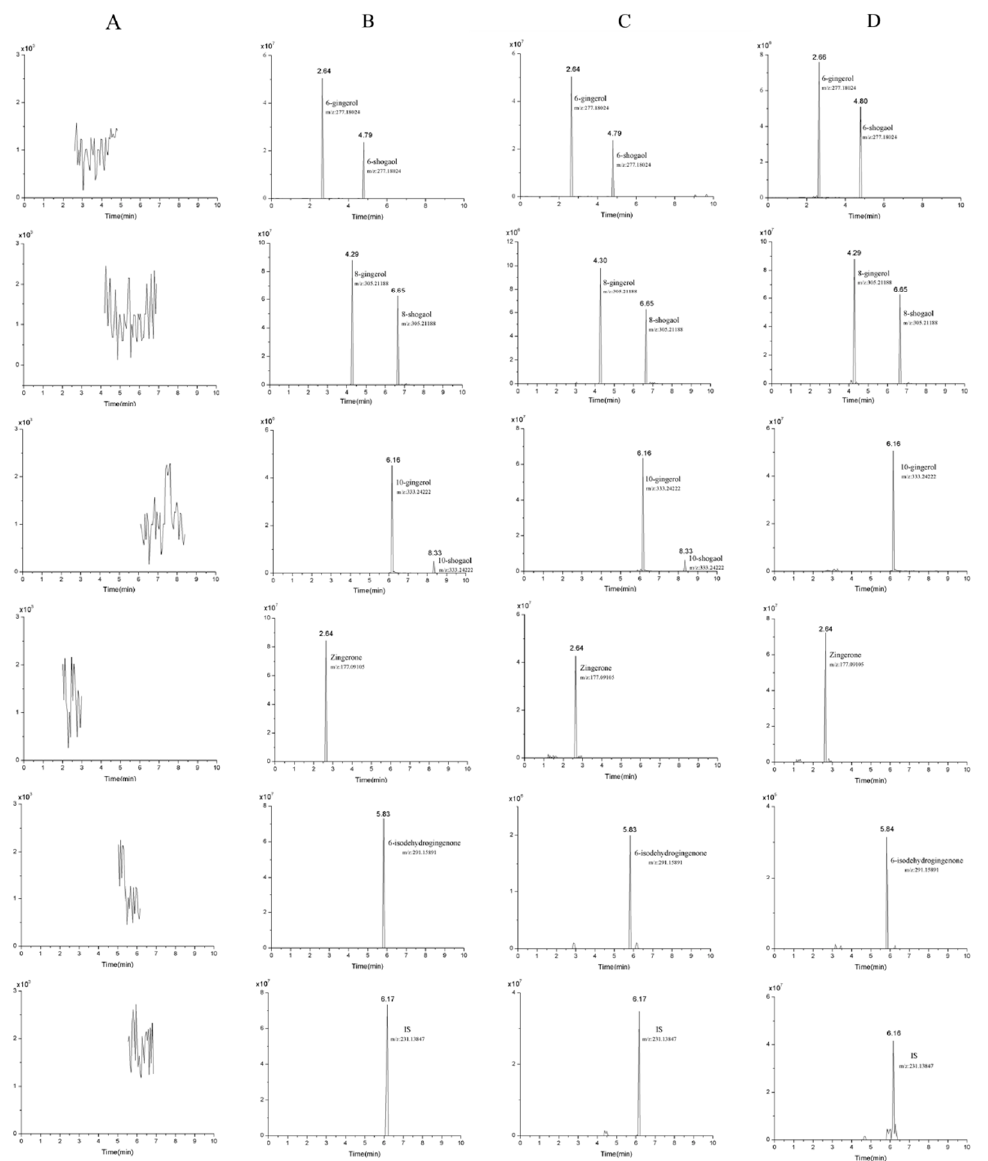
Figure 2. Representative chromatograms of eight analytes and IS: Blank plasma ( A ); blank plasma spiked with analytes and IS ( B ); plasma ( C ) and lung sample ( D ) collected at 1 h after oral administration of ginger extract at a dose of 400 mg/kg.